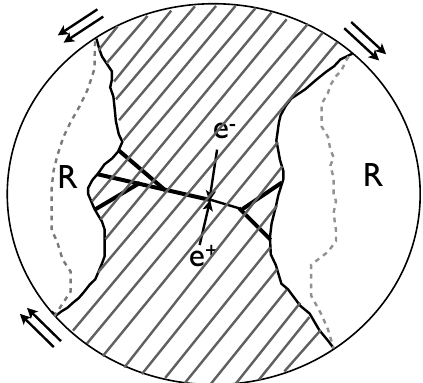
Figure 2 . Minimal example of a non-global observable: the total cross-section to produce particles inside a given potato-shaped allowed region R , allowing only a small total energy E out outside of it. In the limit E out ! 0, large logarithms need to be resummed, which suppress the cross-section: the e(cid:11)ective excluded region grows as the veto suppresses near-boundary